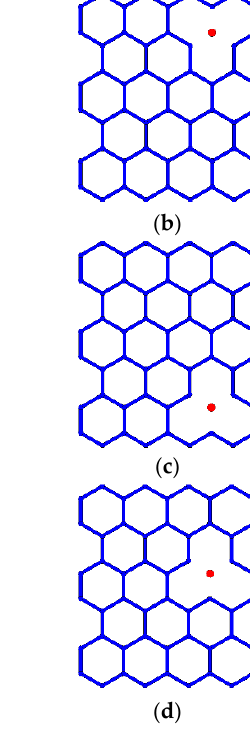
Figure 1. Schematic for graphene honeycomb lattice and examples of atomic vacancy defects (( a ) presents the periodic honeycomb lattice of pristine graphene, ( b – d ) provide the examples of atomic vacancy defects in the y -axis direction, ( d – f ) present the atomic vacancy defects located in the x -axis direction).